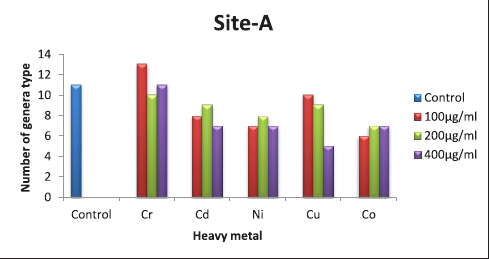
Fig. 2a. Diversity of soil fungal genera at different concentration of heavy metals at site-A.